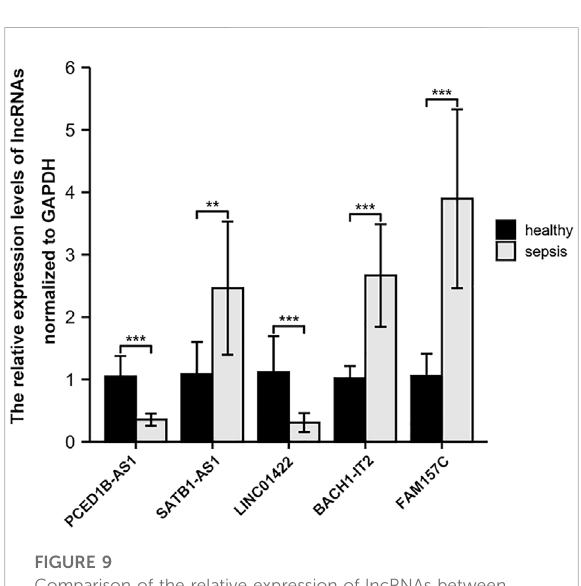
FIGURE 9 Comparison of the relative expression of lncRNAs between sepsis patients and healthy control subjects. pp , p < 0.001; ppp , p <